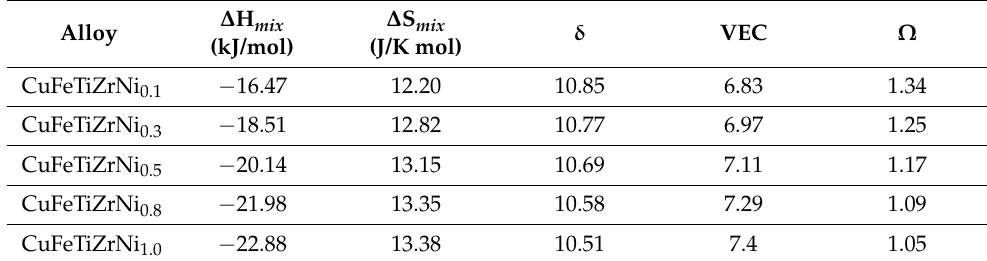
Table 2. ∆ H mix , ∆ S mix , δ , VEC, and Ω values for the CuFeTiZrNi x